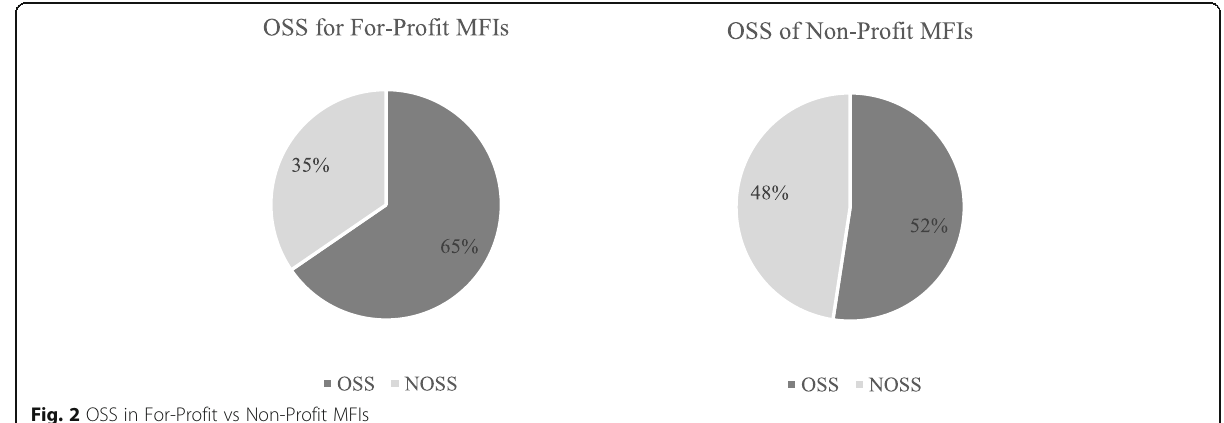
Fig. 2 OSS in For-Profit vs Non-Profit